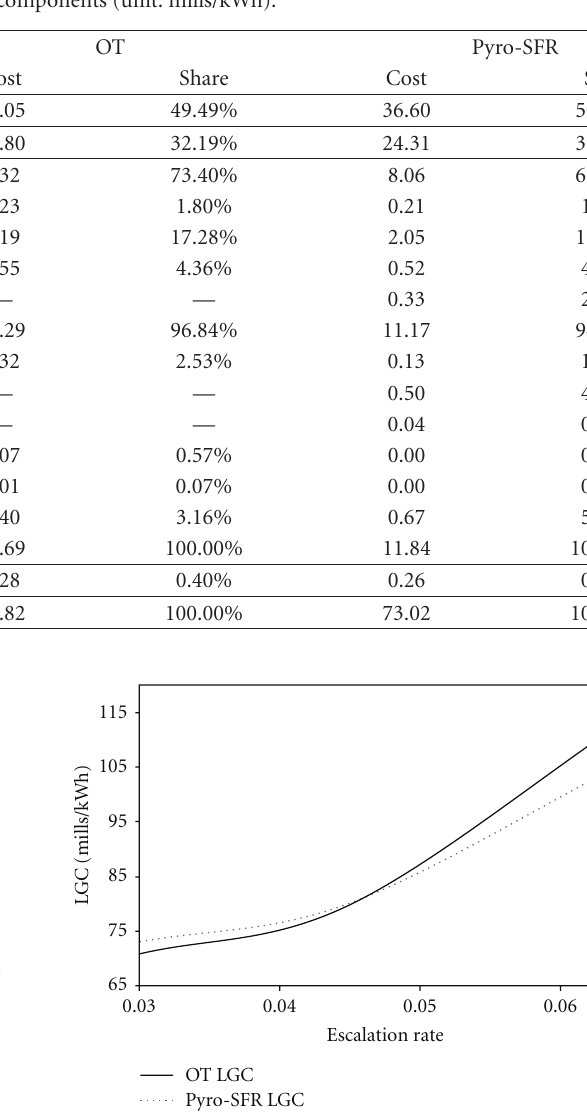
Table 4: Levelized cost components (unit: mills/kWh).